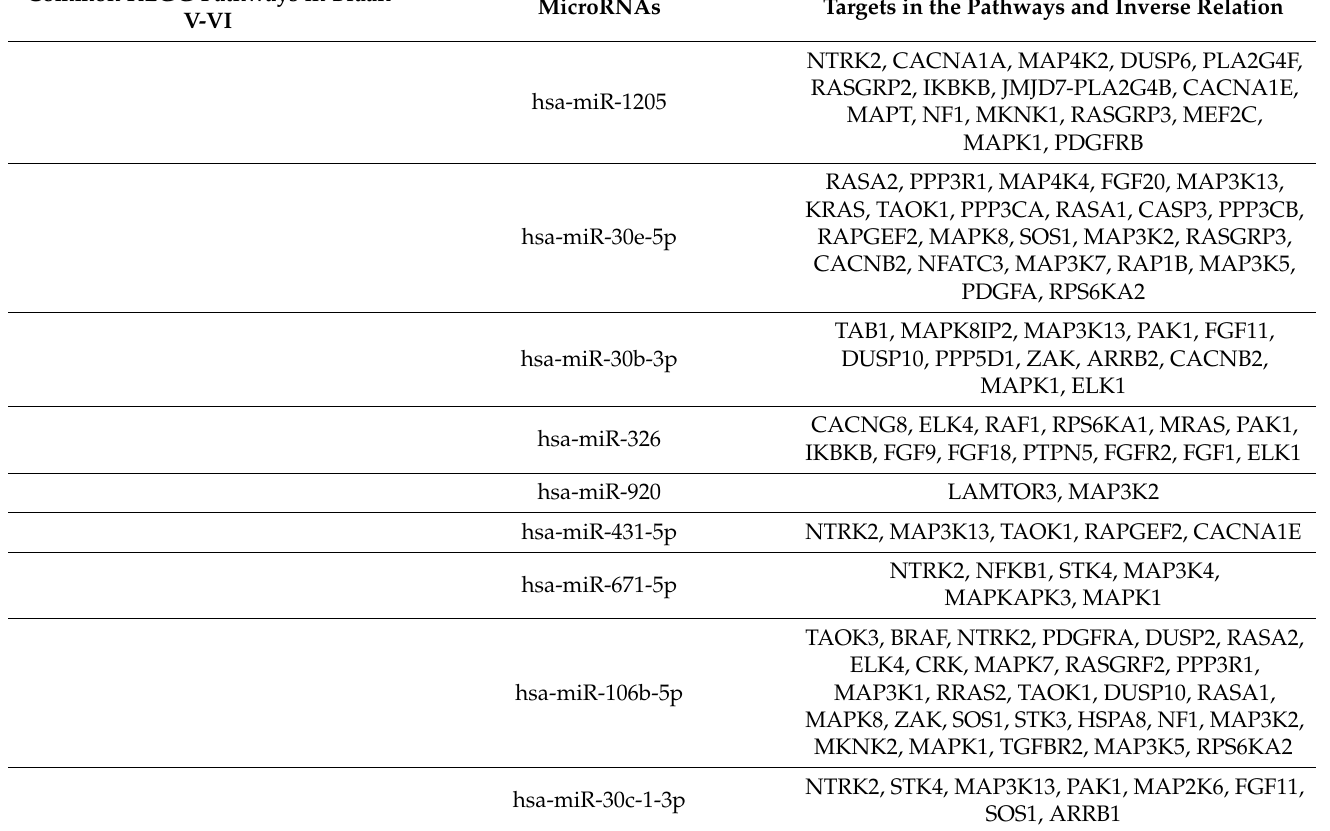
Common KEGG Pathways in